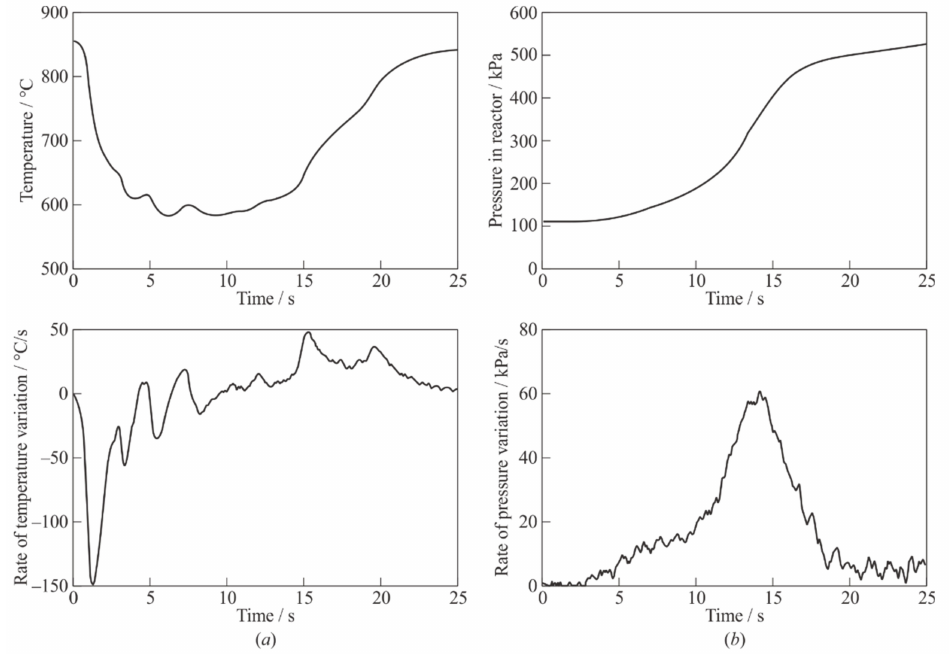
Figure 4. Time histories of pyrogas temperature and the rate of temperature variation ( a ) and pressure and the rate of pressure variation ( b ) in a closed GG at m 0 = 1 g and T p ≈ 850 ◦ C.